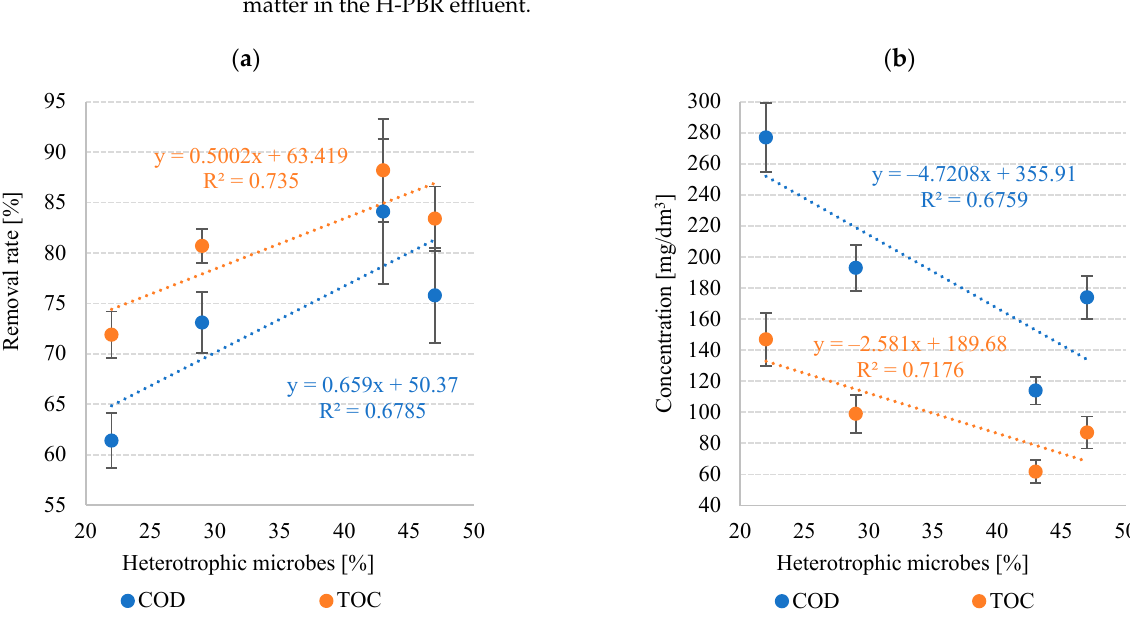
Figure 13. Correlations between M-BGS levels and ( a ) organics removal and ( b ) levels of organic matter in the H-PBR effluent.